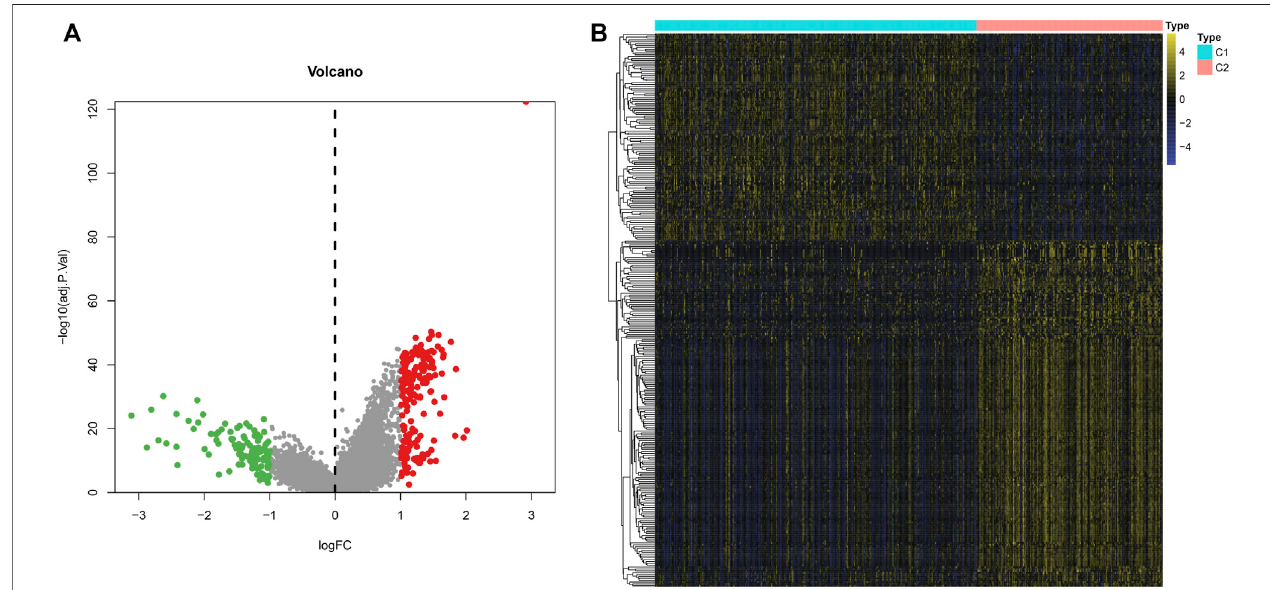
FIGURE 4 | Identi fi cation of DEGs between two m 6 A modi fi cation patterns across LUAD samples from the TCGA dataset. (A) The volcano map of 297 genes that were abnormally expressed between two m 6 A modi fi cation patterns. Red dots indicated genes with high expression in C1 and green dots represented genes with low expression in C1. (B) Hierarchical clustering analysis of the 297 m 6 A-related DEGs in LUAD samples from two m 6 A modi fi cation patterns.